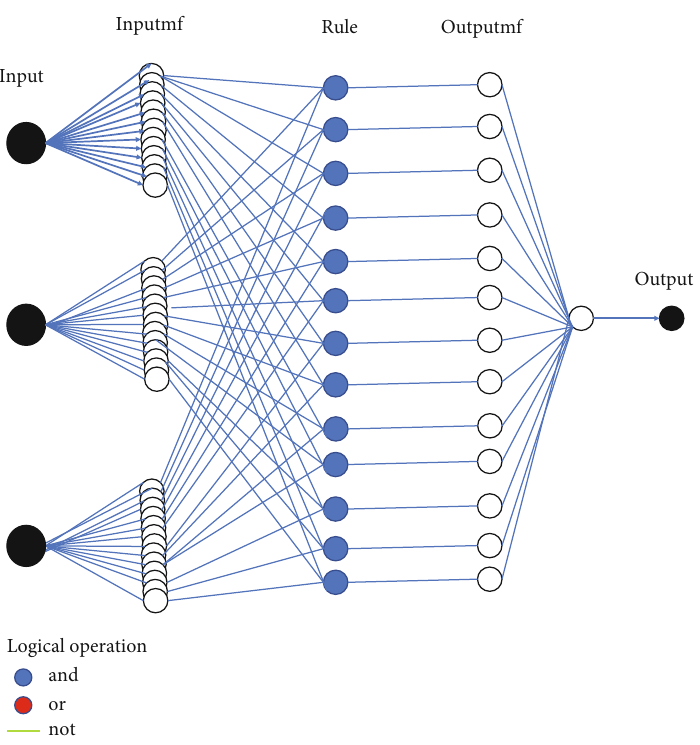
Figure 5: Schematic diagram of optimized ANFIS. Table 5: Modeling performance of